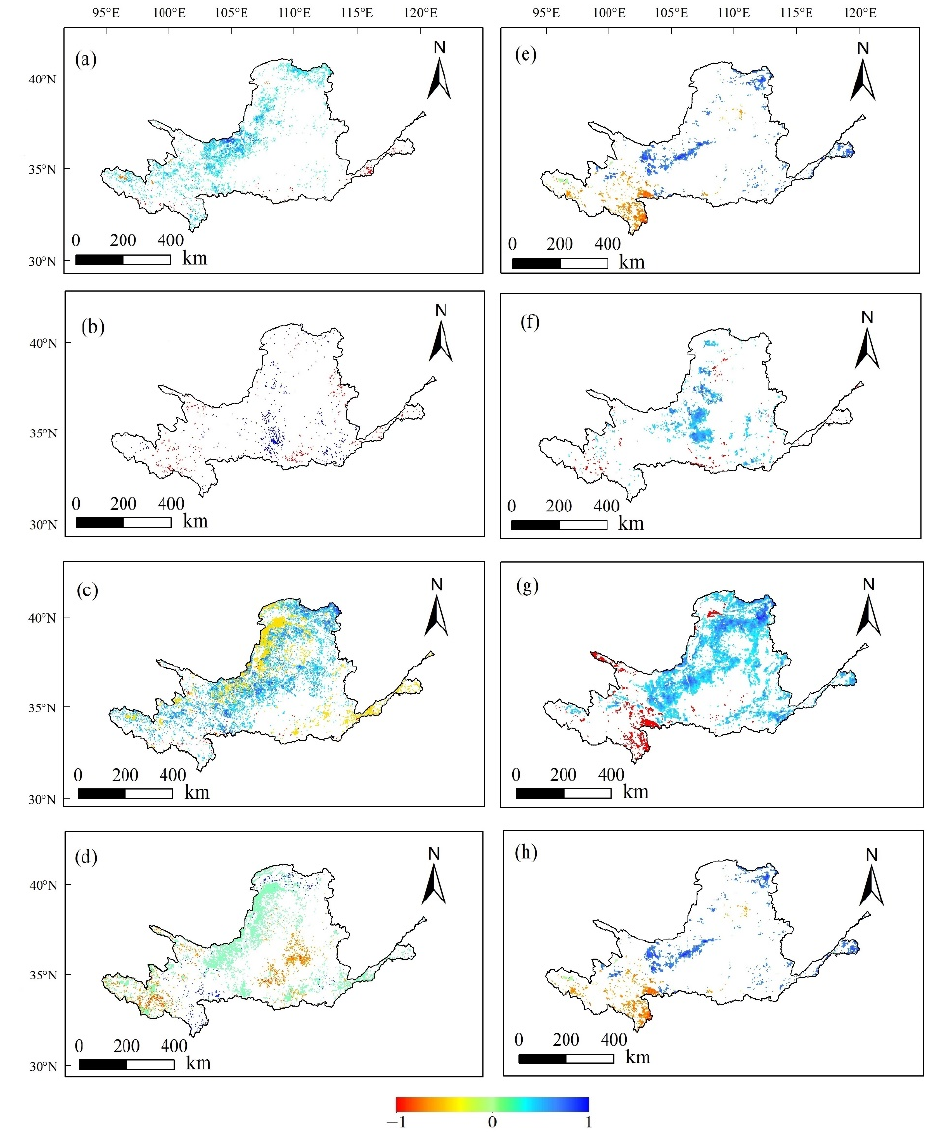
Figure 9. Response of NDVI to SPEI in different seasons ( p < 0.05). ( a ) Annual; ( b ) Spring; ( c ) Summer; ( d ) Autumn. Response of SIF to SPEI in different seasons ( p < 0.05). ( e ) Annual; ( f ) Spring; ( g ) Summer; ( h ) Autumn.